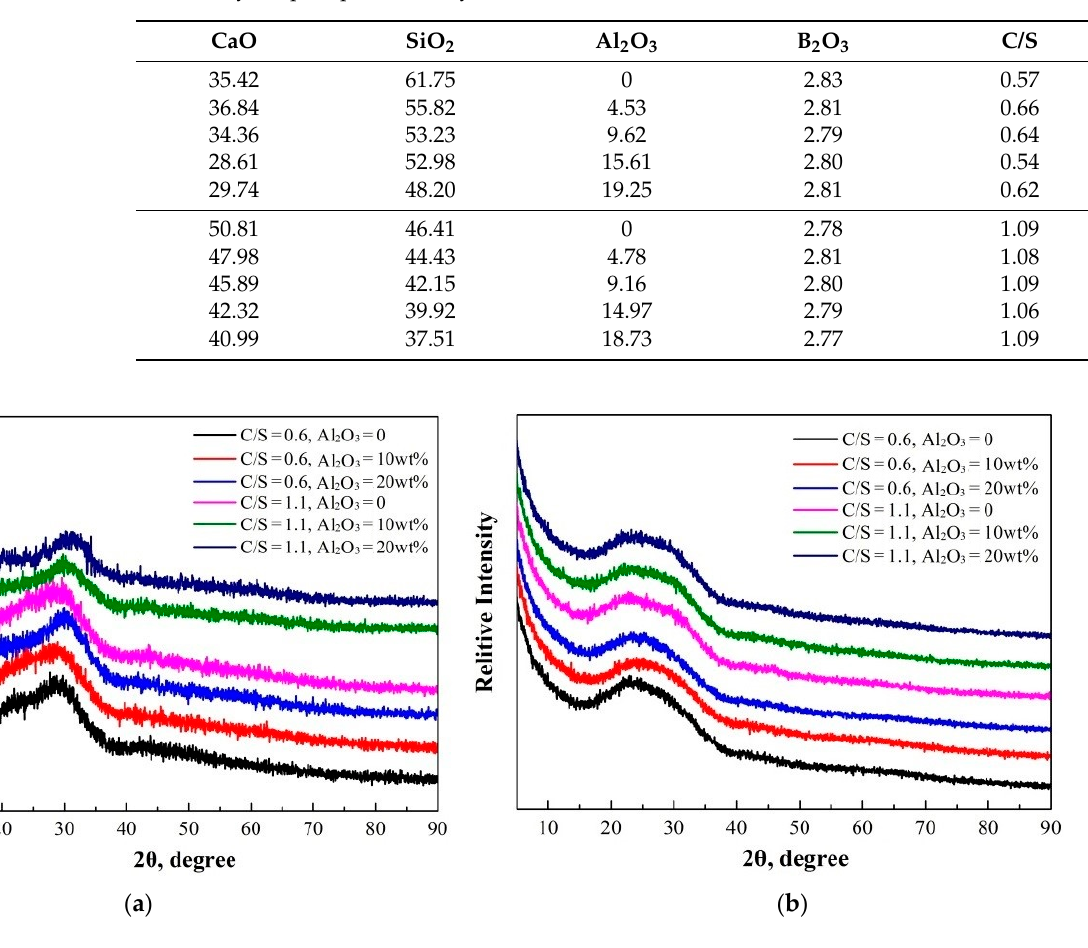
Table 3. Pre-melting slag components with B 2 O 3 , as determined from X-ray fluorescence and in- ductively coupled plasma analysis, mass%.